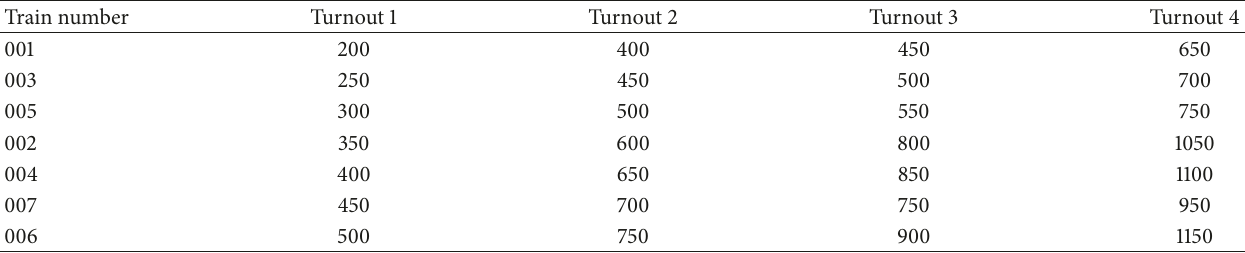
Table 3: The newly generated timetable through B&B algorithm in case of delay.